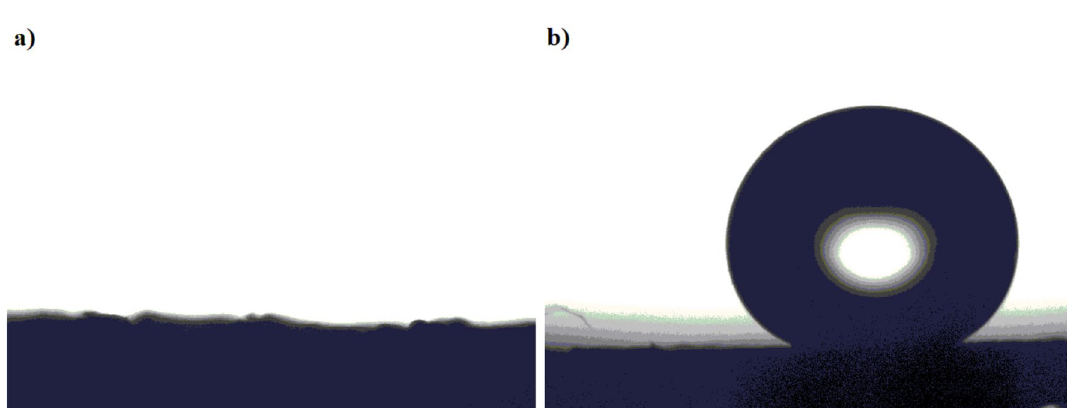
Figure 6. SEM images of the pristine ( a ) and modified textile fabric ( b ).